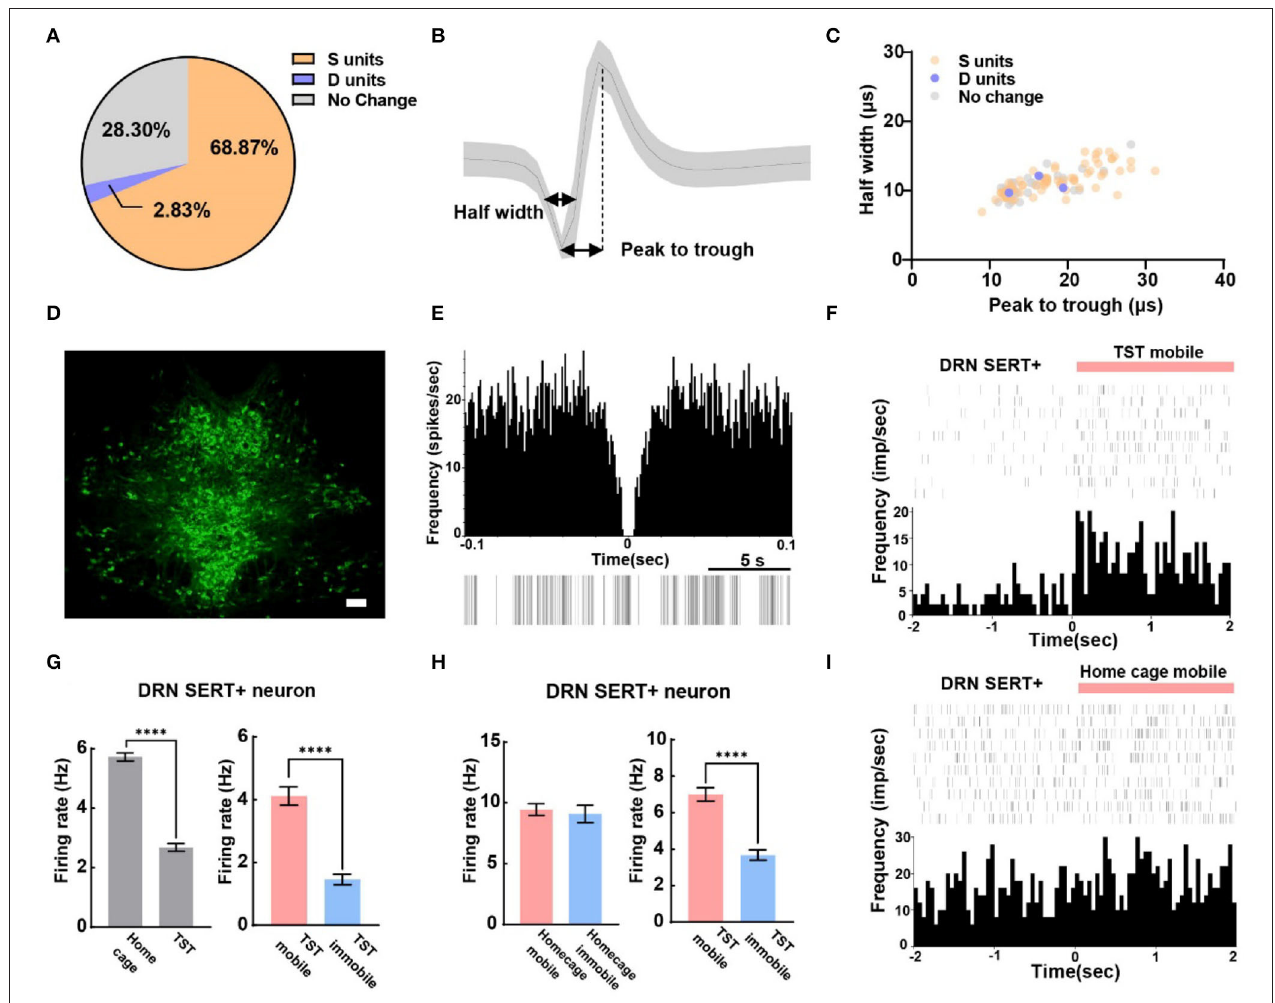
FIGURE 3 | The majority of serotonergic neurons in DRN are putative survival units. (A) Proportion of different types of units recorded in DRN SERT + neurons. N = 13, n = 106, S units = 73, D units = 3. (B) Example of measuring the half width and peak to trough of a waveform. (C) Scatterplot of different units based on their spike waveform of DRN SERT + neurons which identified by optogenetics. (D) Representative photomicrographs (10X) of TPH2 antibody-stained serotonin neurons in DRN. Bar, 100 µ m. (E) The autocorrelogram, waveform, and the raster of a single SERT + neuron recorded in this study, respectively. (F) Spike frequency of an example DRN SERT + neuron from the TST immobile to mobile stages. (G) Bar pot of DRN serotonergic neuron that is inhibited during TST (left), especially in immobile states (right). (H) Bar pot of serotonergic neuron that is only inhibited in TST immobile states (right) not home cage immobile (left). (I) Spike frequency of an example DRN SERT + neuron from home cage immobile to mobile stages (two-tailed unpaired t -test, **** p <